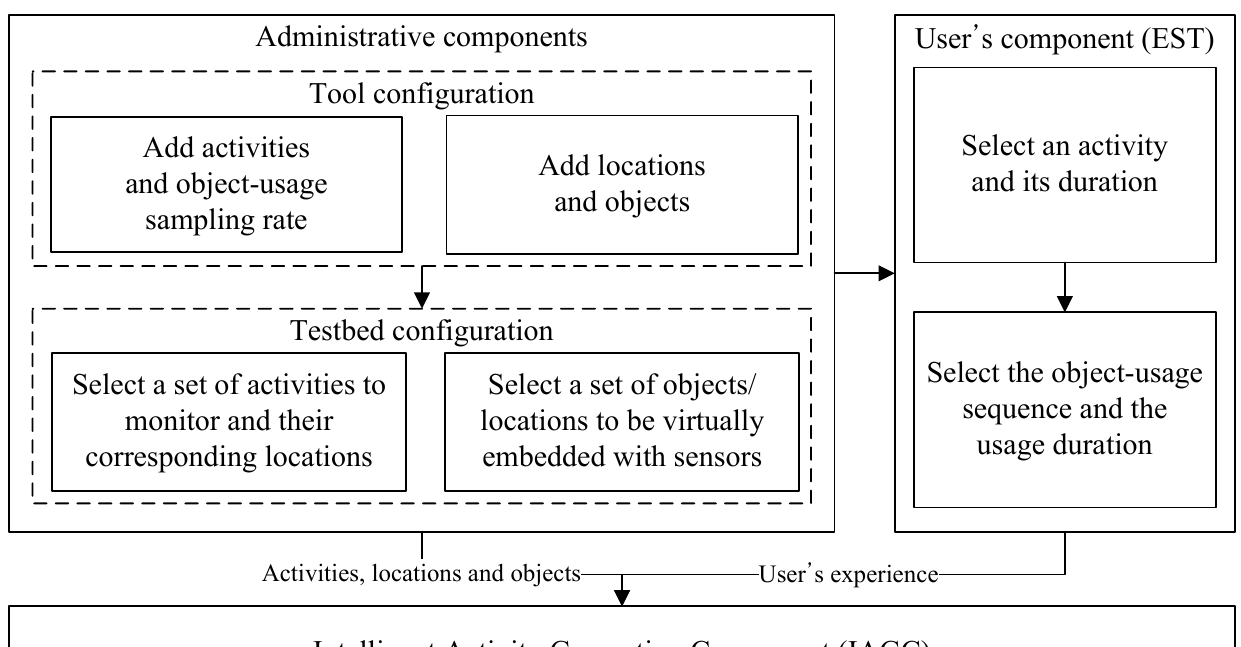
Figure 1. Overview of the tool for real-world activity data